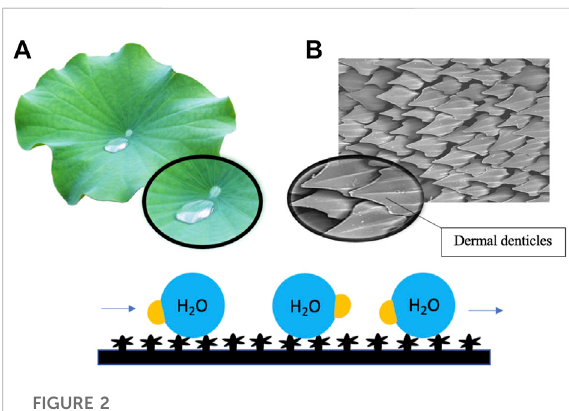
FIGURE 2 Surface roughness induced by hierarchical micro- and nanostructures of lotus leaves (A) and shark skin (B) renders the surface superhydrophobic and low in surface energy, resulting in the repulsion of water droplets and reducing adhesive forces between settling bacteria and the surface. Dirt particles and debris are picked up by fl owing water droplets on the